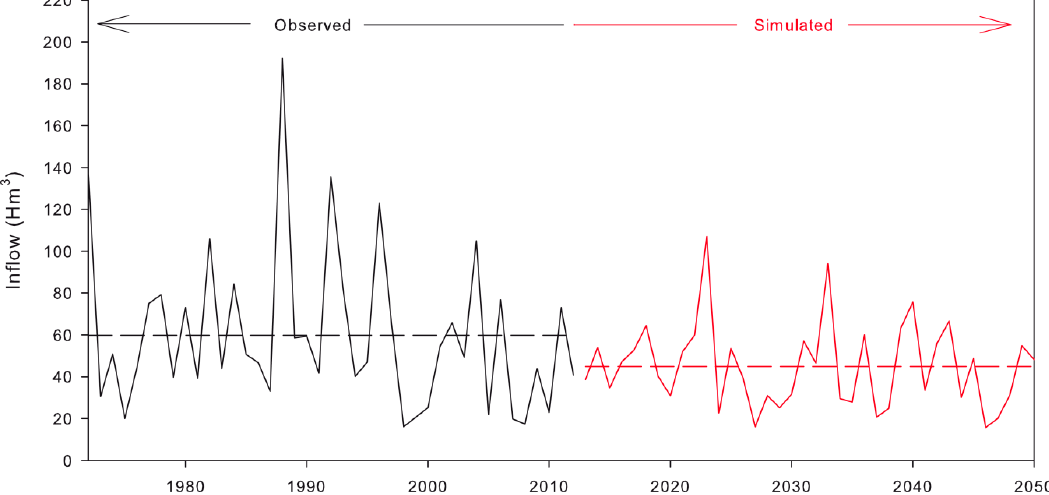
Figure 12. Annual dam inflow (hm 3 ) for observed period 1971–2011 (black line) and simulated 2012–2050 (red line). Dashed lines show the average of each period.